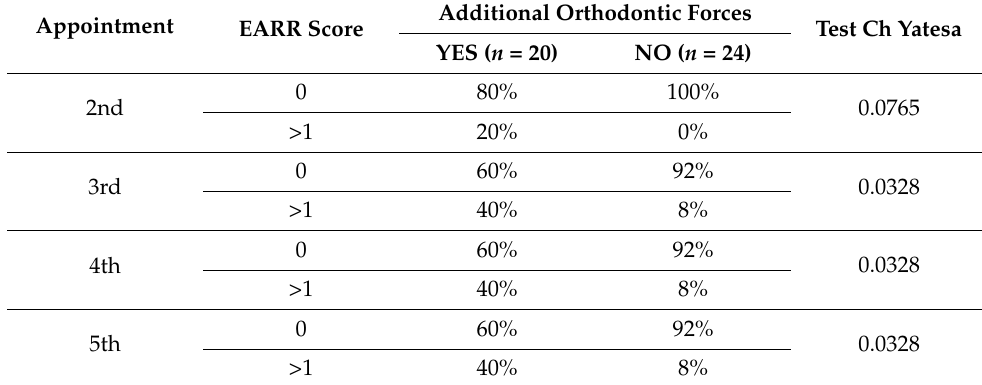
Table 10. The percentage distribution of endodontically treated teeth with observed external apical root resorption. The additional forces used.